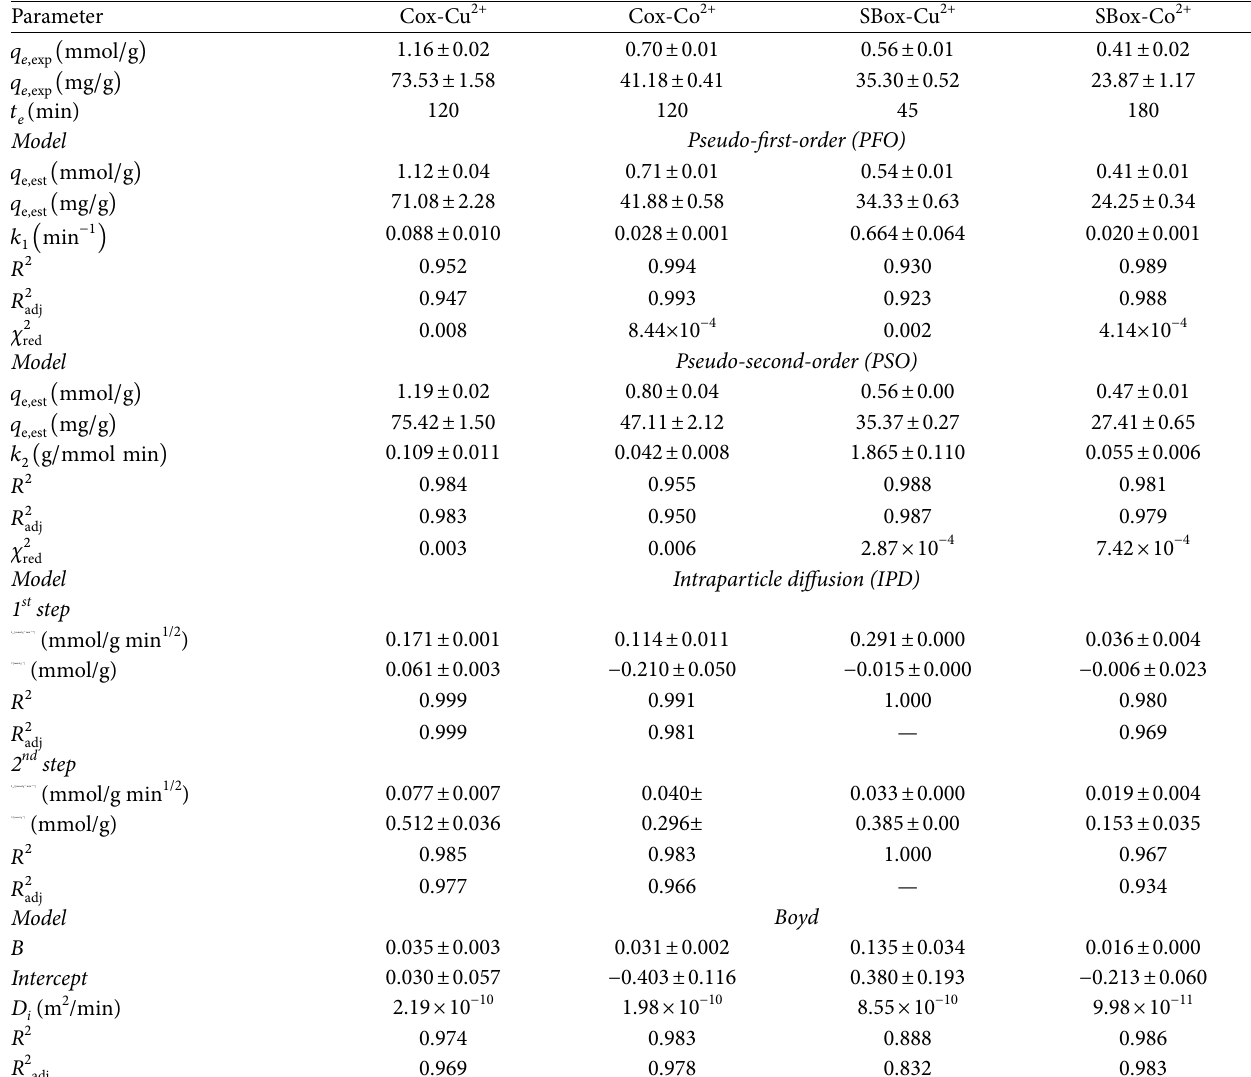
Table 2: Results of modeling the experimental kinetic data for the adsorption of Cu 2+ and Co 2+ on Cox and SBox (25°C, 150 rpm, pH